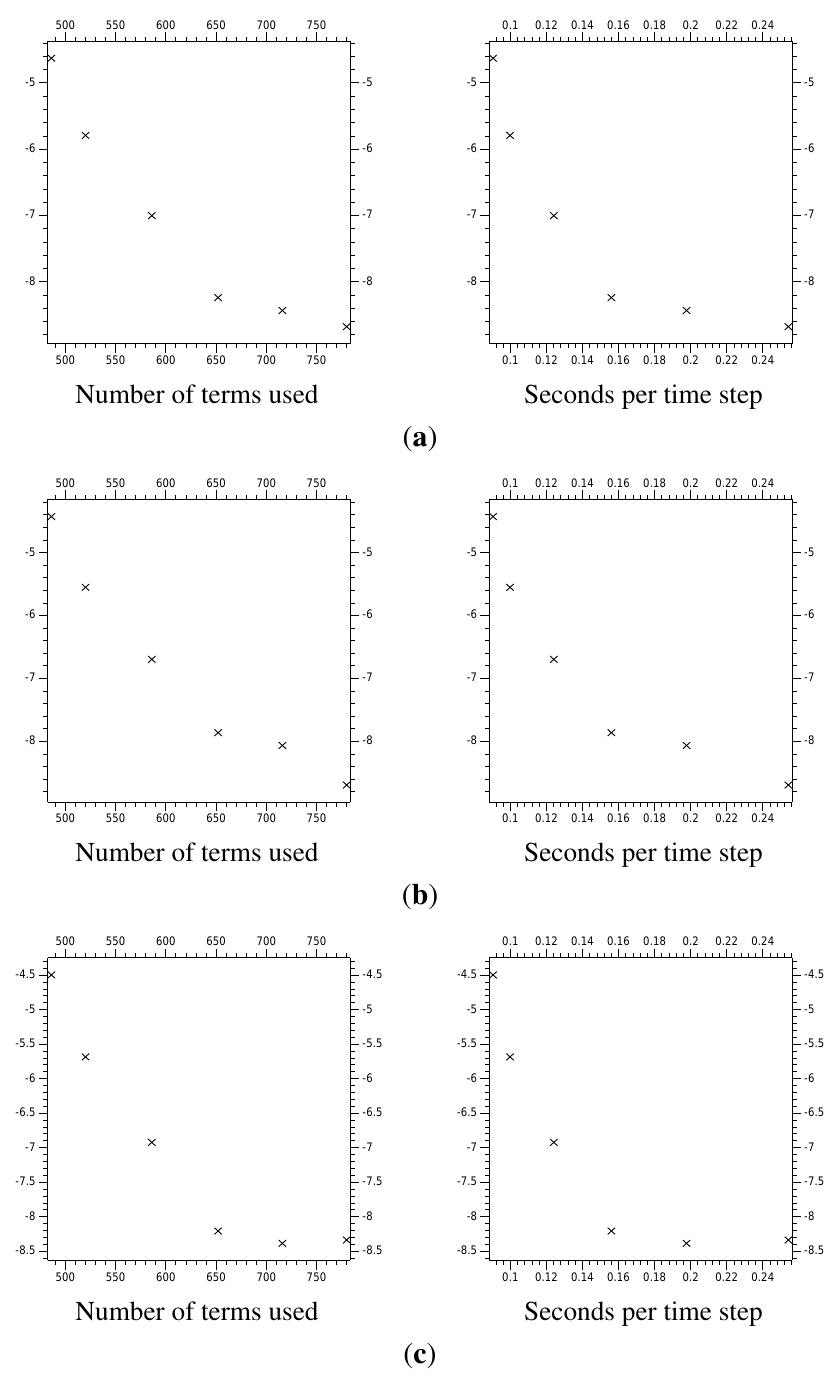
Figure 9. Error from multi-scale systems, compared with system size and computational time. The system size is the total number of coefficients a and b used in the systems j;k j;k (also seen in Table 1). The computational time is the average time taken to calculate a single time step, in seconds (all using the same computer). The vertical axis is the log of the error, 10 the difference between the multi-scale results and the fine resolution control results on (1.5, 8.5). ( a ) log of the L 2 error; ( b ) log of the L 1 error; ( c ) log of the L ∞ 10 10 10